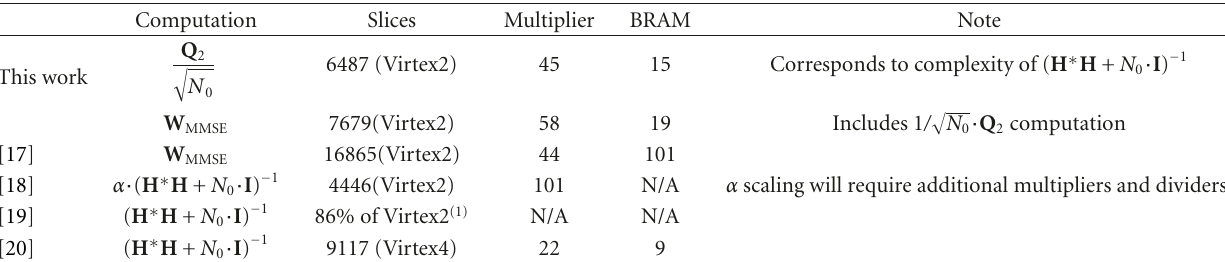
Table 7: Resource usage comparison.